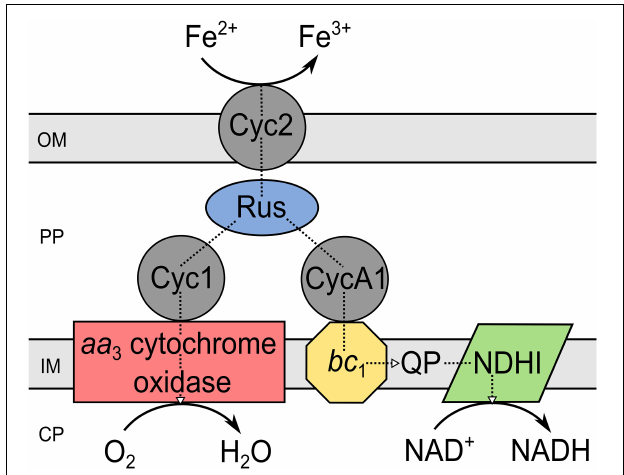
FIGURE 2 | Components of the iron oxidation pathway in Acidithiobacillus ferrooxidans . The scheme is a modified version of that given by Ilbert and Bonnefoy (2013). PP, periplasm; CP, cytoplasm; OM, outer membrane; IM, inner membrane; Cyc, cytochrome c ; Rus, rusticyanin; QP, quinol pool; NDHI, NADH dehydrogenase complex; bc 1 , cytochrome bc 1 complex (encoded by petI/II